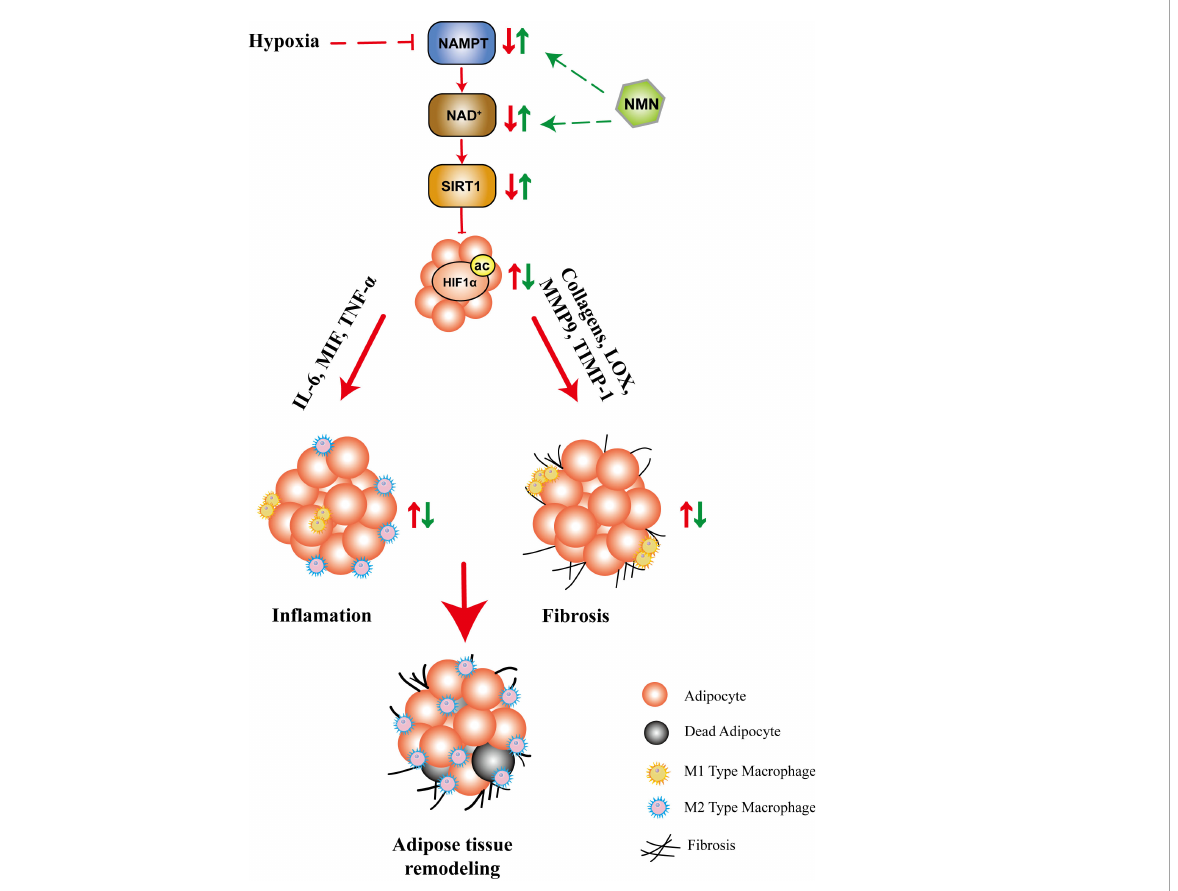
FIGURE 6 The proposed mechanisms for the protective role of NMN in hypoxia-induced adipose tissue remodeling. Hypoxia led to compromised NAMPT/NAD + / SIRT1 axis, which further promoted HIF1 a activation. As a result, the fi brotic and in fl ammatory response are signi fi cantly increased, accompanied by adipocytokine dysregulation, which ultimately lead to adipose tissue remodeling. NMN restored the NAMPT/NAD + /SIRT1 axis and inhibited HIF1 a activation, which further attenuated adipose tissue